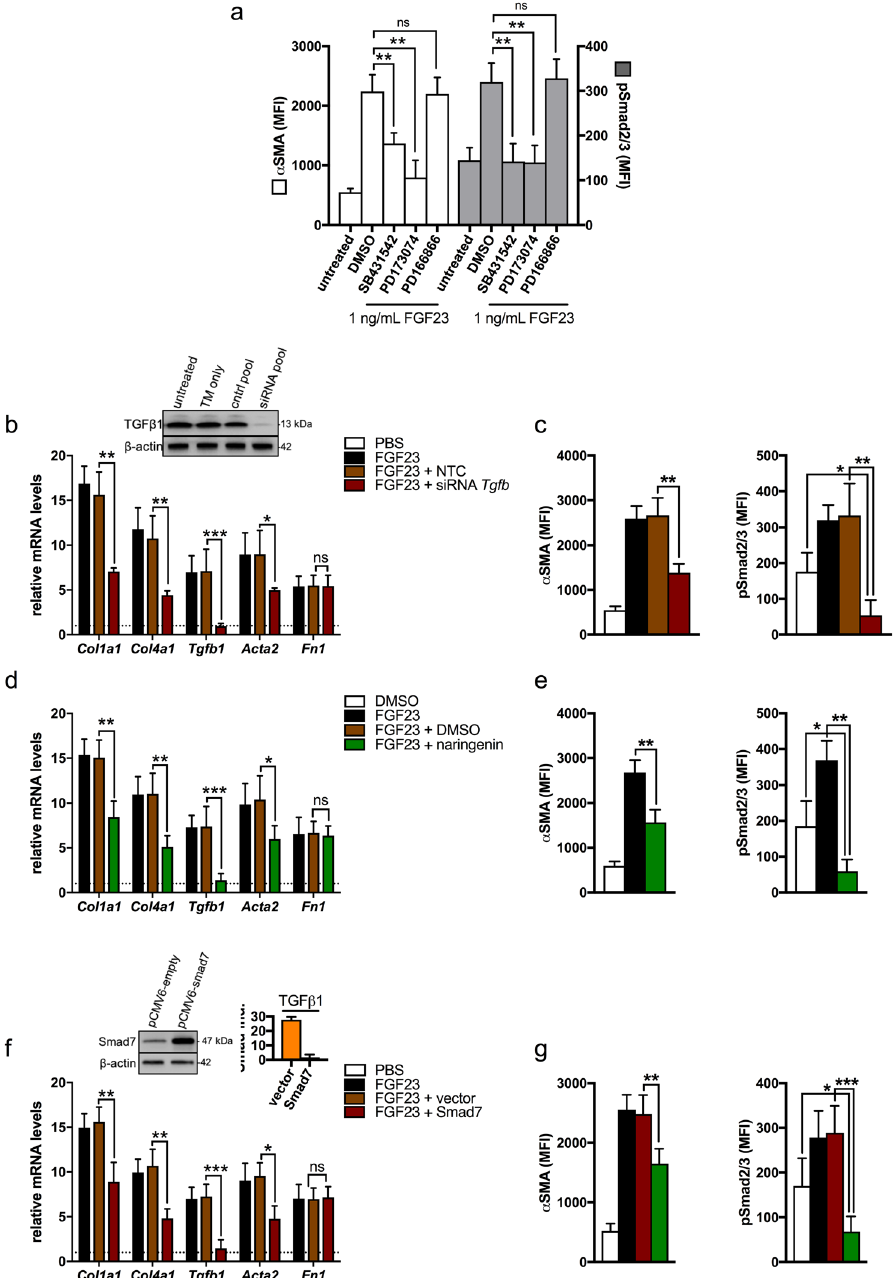
Figure 8. Effects of FGF23 on UUOF are mediated by FGFR and activation of TGF- β 1 signalling. ( a ) The effect of pre-treatment with SB431542 (TGFBR1 inhibitor), PD173074 (pan FGFR inhibitor), PD166866 (selective FGFR1 inhibitor), or DMSO (vehicle) on FGF23-induced changes (1 ng/mL for 24 h) in α SMA and pSmad2/3, as analysed by quantitative flow cytometry. ( b , c ) The effect of Tgfb1 specific siRNAs on fibrogenic gene expression using qRT-PCR ( b ), α SMA levels and pSmad2/3 protein levels ( c ) in UUOF treated with FGF23 (1 ng/mL for 24 h), compared to a non-targeting control (NTC) pool. Representative Western blot of TGF- β 1 silencing shown above. ( d , e ) The effect of pre-treatment with naringenin (Smad 3 inhibitor) on fibrogenic gene expression using qRT-PCR ( d ), α SMA levels and pSmad2/3 protein levels ( e ) in UUOF treated with FGF23 (1 ng/mL for 24 h), compared to a NTC pool. ( f , g ) The effect of transient overexpression of Smad7 (endogenous Smad inhibitor) on fibrogenic gene expression using qRT-PCR ( f ), and quantitative flow cytometric analysis of α SMA levels and pSmad2/3 ( g ) in UUOF treated with FGF23 (1 ng/mL for 24 h), compared to cells transfected with empty vector. Representative Western blot (upper left ‘ f ’) of Smad7-transfected UUOF. Suppression of Smad signalling was confirmed using a reporter assay as previously described (upper right ‘ f ’). Data are shown as mean ± SD and represent at least three independent experiments with similar results. * P < 0.05; ** P < 0.01; *** P < 0.001; ns, not significant. P-values were determined by one-way ANOVA with Holm-Sidak multiple comparisons